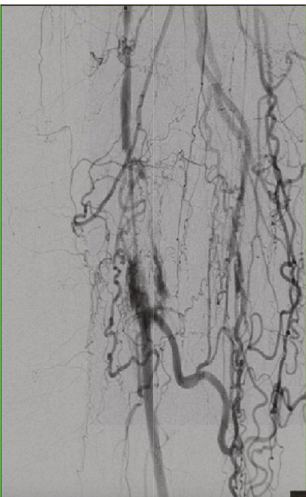
Figure 4: Complete resolution of perforation and a large collateral branch that is jailed by the